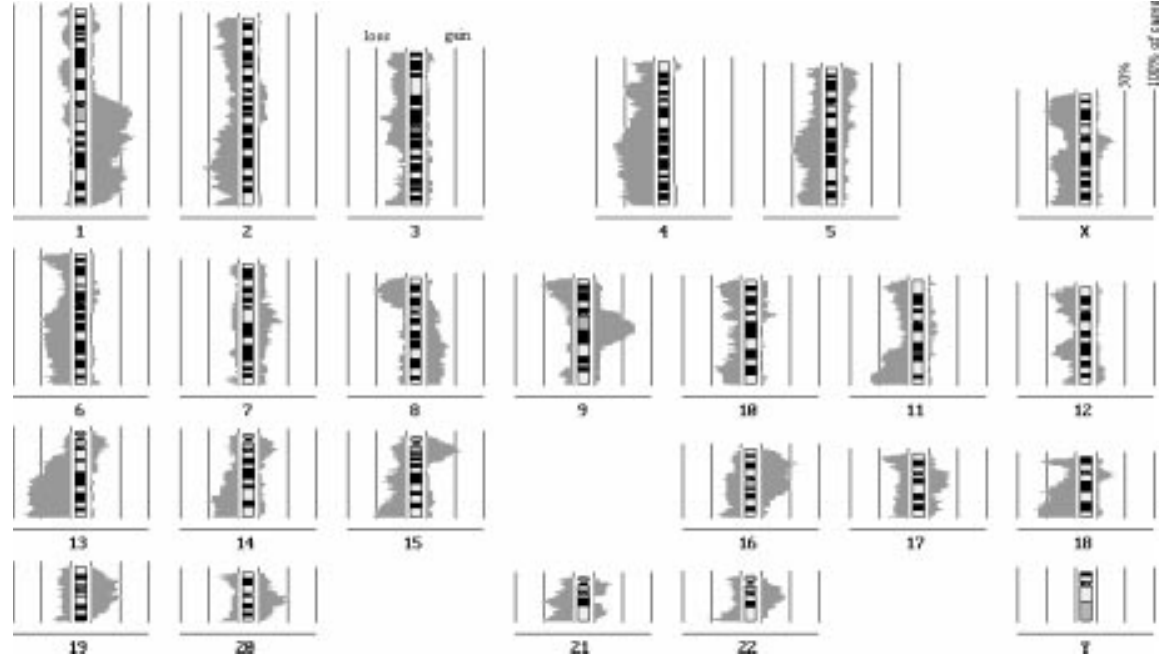
Fig. 6. Histogram of the CGH result of 21 aneuploid breast cancers shown by gray areas besides the chromosome ideograms. Significance level of 95% for gains or losses in the Student’s t